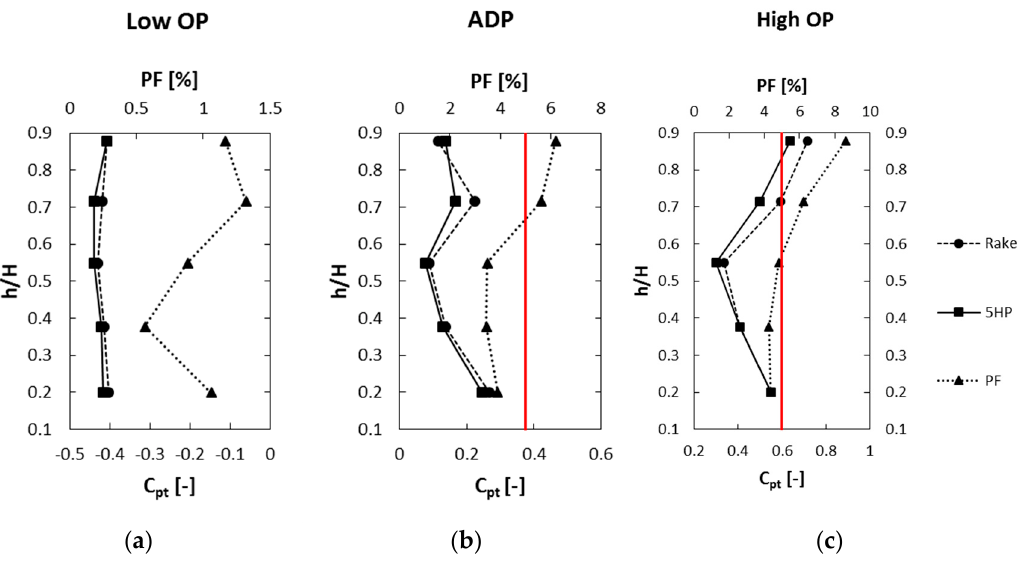
Figure 7. Comparison of percentage pressure fluctuation (PF) with rake and 5HP results regarding the difference between these two measurement techniques ( a ) low OP; ( b ) ADP; and ( c ) high OP.